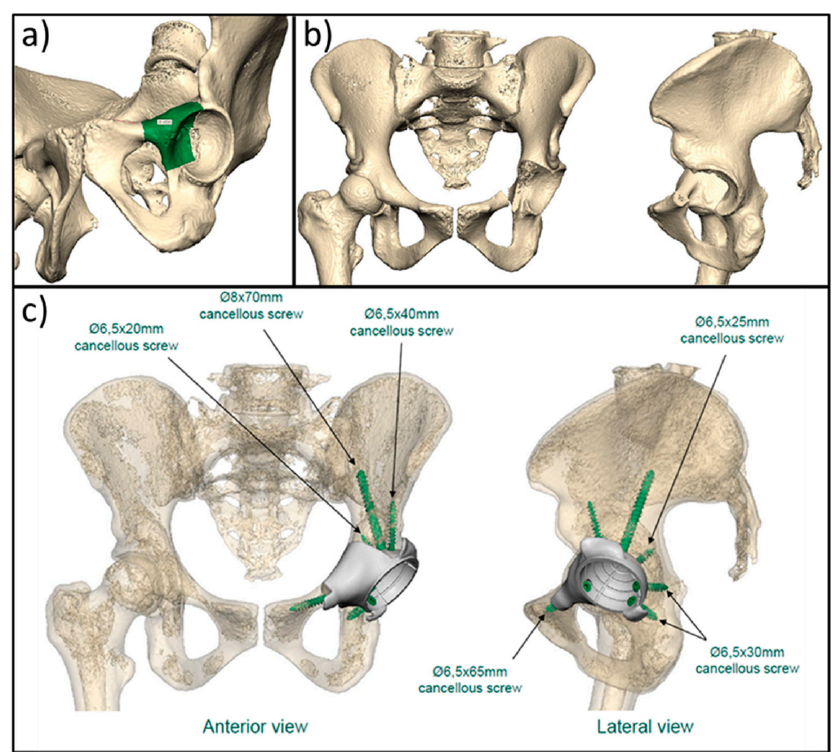
Figure 8. Images show the planning stages of a 3D implant. ( a ) Shows the identification of the margins required on a 3D image of the patient’s pelvis, whilst ( b ) Shows an image of the patient’s pelvis post resection. This identifies the deficit that needs to be replaced, which can then be designed, as shown in ( c